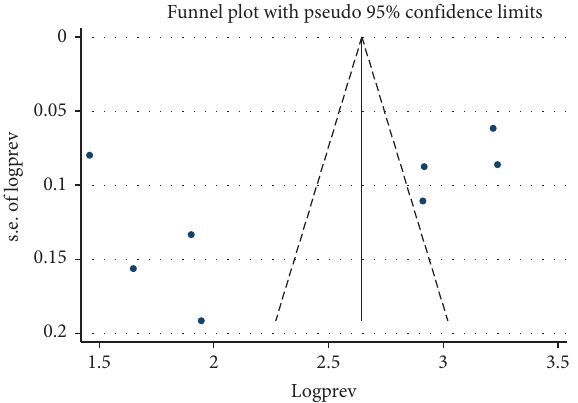
Figure 5: Funnel plots indicate absence of publication bias across studies included in this review in Ethiopia, 2020.